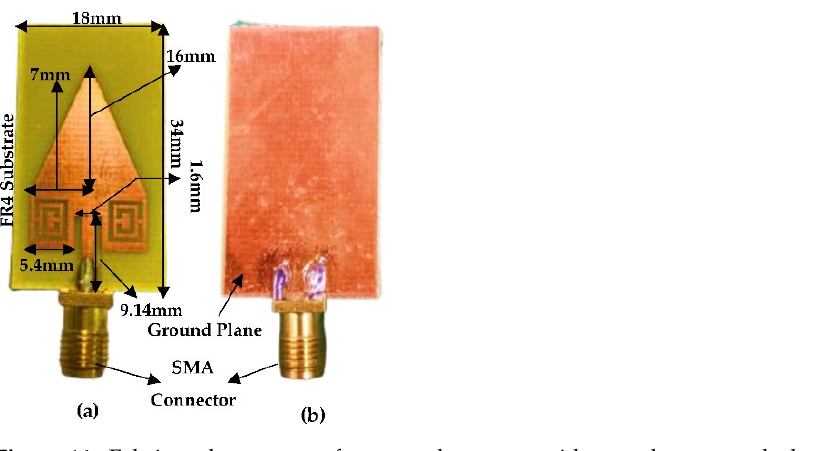
Figure 15. Fabricated structure of proposed antenna with cross-slot MTM structure etched on the ground plane ( a ) Top Layer ( b ) Bottom Layer. Figure 16. Simulated and Measured S-Parameter response ( a ) Proposed antenna with the complete ground plane ( b ) Proposed antenna with 3 × 3 cross-slot MTM structure etched on the ground plane. The simulated and measured E- & H-plane radiation patterns proposed antenna with complete are shown in Figure 17a,b. The proposed antenna shows the maximum simu- lated and measured gain of 2.9 dBi and 2.6 dBi, respectively. From Figure 17a,b, it can be understood that the antenna radiates in the boresight. The measured radiation pattern slightly deviates from 0° as compared to the simulated result. Figure 18a,b shows the E- and H-plane radiation pattern of the proposed antenna with 3 × 3 cross-slot MTM etched in the ground plane, respectively. It has a maximum simulated and measured gain of 2.5 dBi and 2.3 dBi, respectively, in the E-Plane. It has a